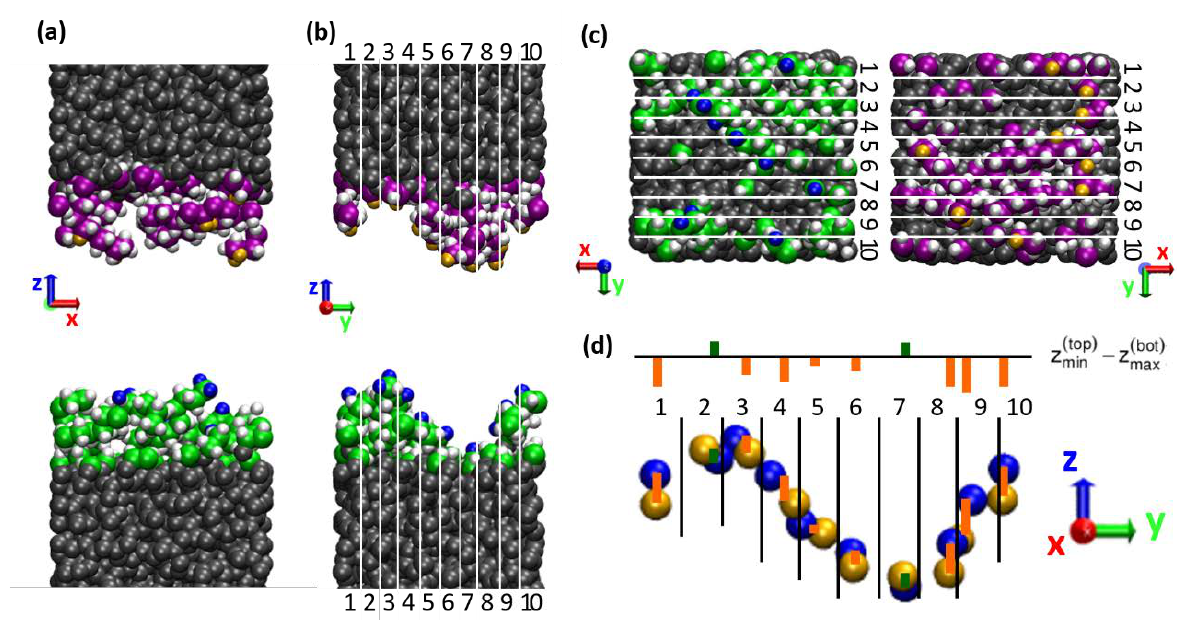
Figure 4. Two-dimensional evaluation of the surface interpenetration. ( a – c ) Snapshot of a system with 5 chains per surface seen from different perspectives: ( a ) perpendicular to and ( b ) along the sliding direction (red x-axis), as well as ( c ) top view on the lower/upper surface. Lower and upper body have been separated in the visualizations for better visibility of the surface atoms. The chains are unevenly distributed over the surface area, which leads to a high apparent interpenetration according to the 1D-density profiles (see Figure 3). The actual interpenetration of surface atoms felt during sliding is much smaller as only the roughness along the sliding direction is sampled. As a rough estimate for this effective roughness, the highest (blue) and lowest (yellow) positioned atoms of the lower and upper body, respectively, are identified in each stripe 1–10. ( d ) Difference between z-positions of the highest/lowest positioned surface atoms of lower/upper body per stripe (see Equation (1); orange/green = negative/positive ∆ z